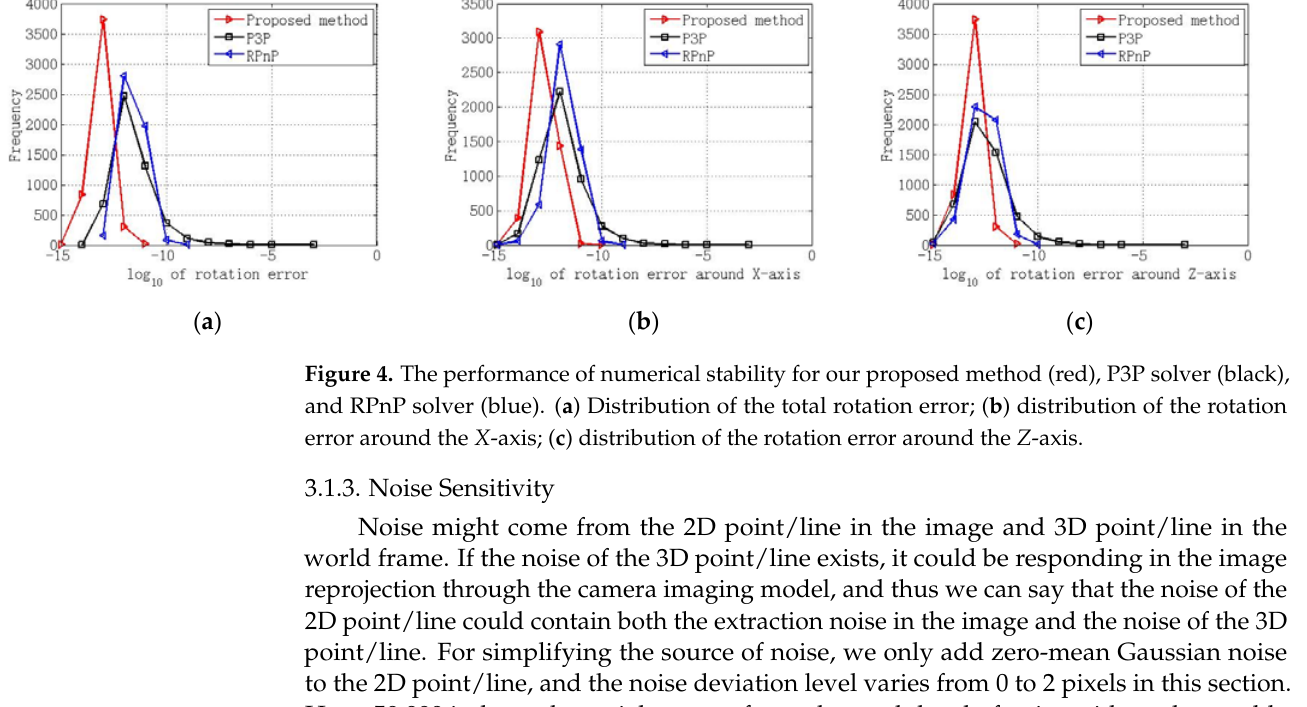
( c ) Figure 3. Robustness to roll angle noise: ( a ) the total rotation error; ( b ) the rotation error around the X ‐ axis; ( c ) the rotation error around the Z ‐ axis. From Figure 3, it can be seen that as the noise in rotation around the Y ‐ axis increases, so does the total rotation error, rotation error around the X ‐ axis, and rotation error around the Z ‐ axis. When the noise in rotation around the Y ‐ axis increases to 0.1°, the maximum error is 0.13° for the total rotation, 0.051° for the rotation around the X ‐ axis, and 0.048° for the rotation around the Z ‐ axis. The maximum errors show that the performance degradation caused by the roll angle noise is very slight, which means our proposed method has a good robustness to roll angle noise.